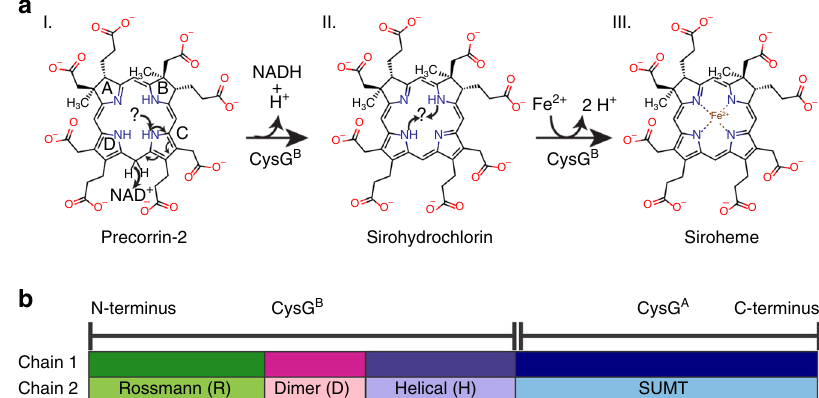
Fig. 1 Overview of siroheme synthesis by the CysG homodimer. a Chemical structures and scheme for the transformation from precorrin-2 to siroheme. b Domain architecture of CysG. The Rossmann fold (R) is colored green throughout; the dimerization domain (d) is colored pink throughout; the all-helical domain (h) is purple throughout; and CysG A is blue throughout. Chain 1 of the dimer is shaded dark throughout and chain 2 of the dimer is shaded light